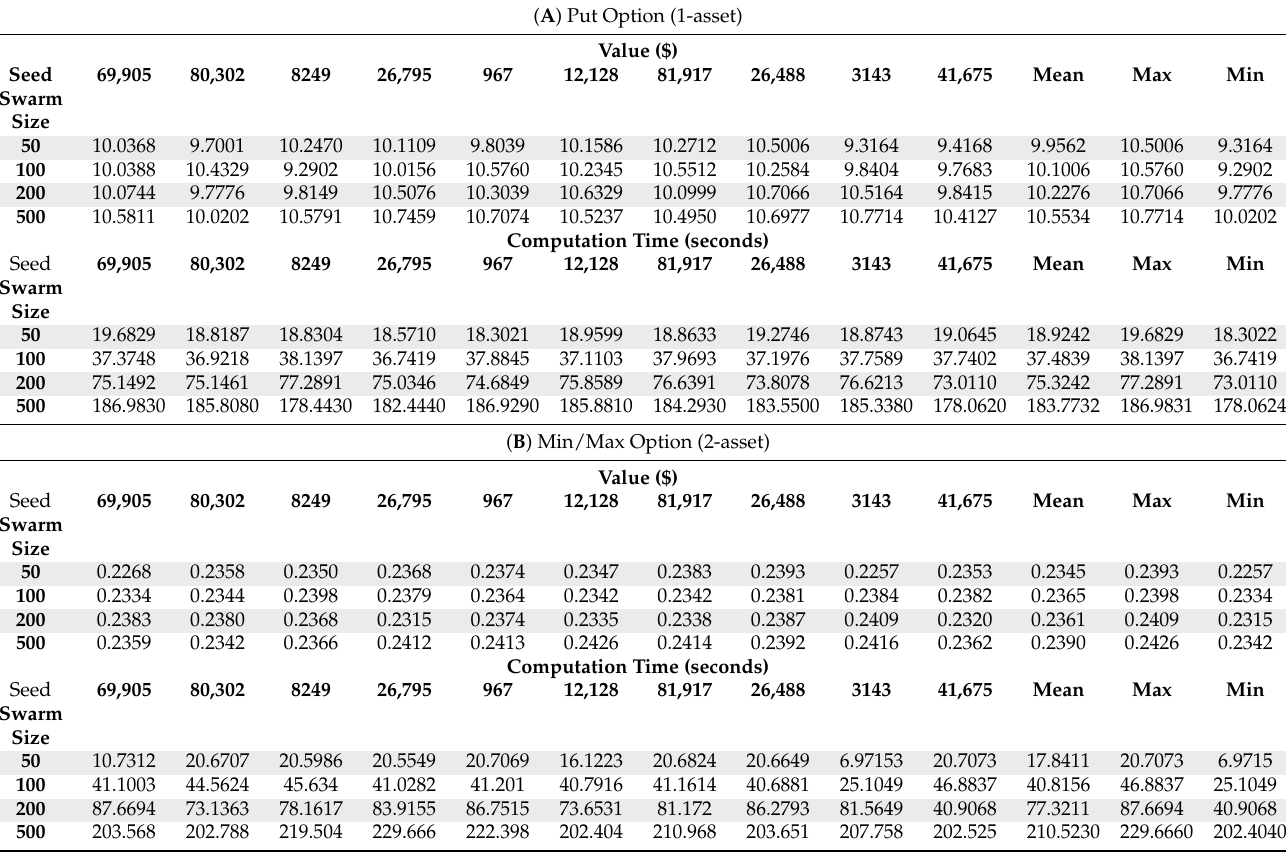
Table 4. Performance of